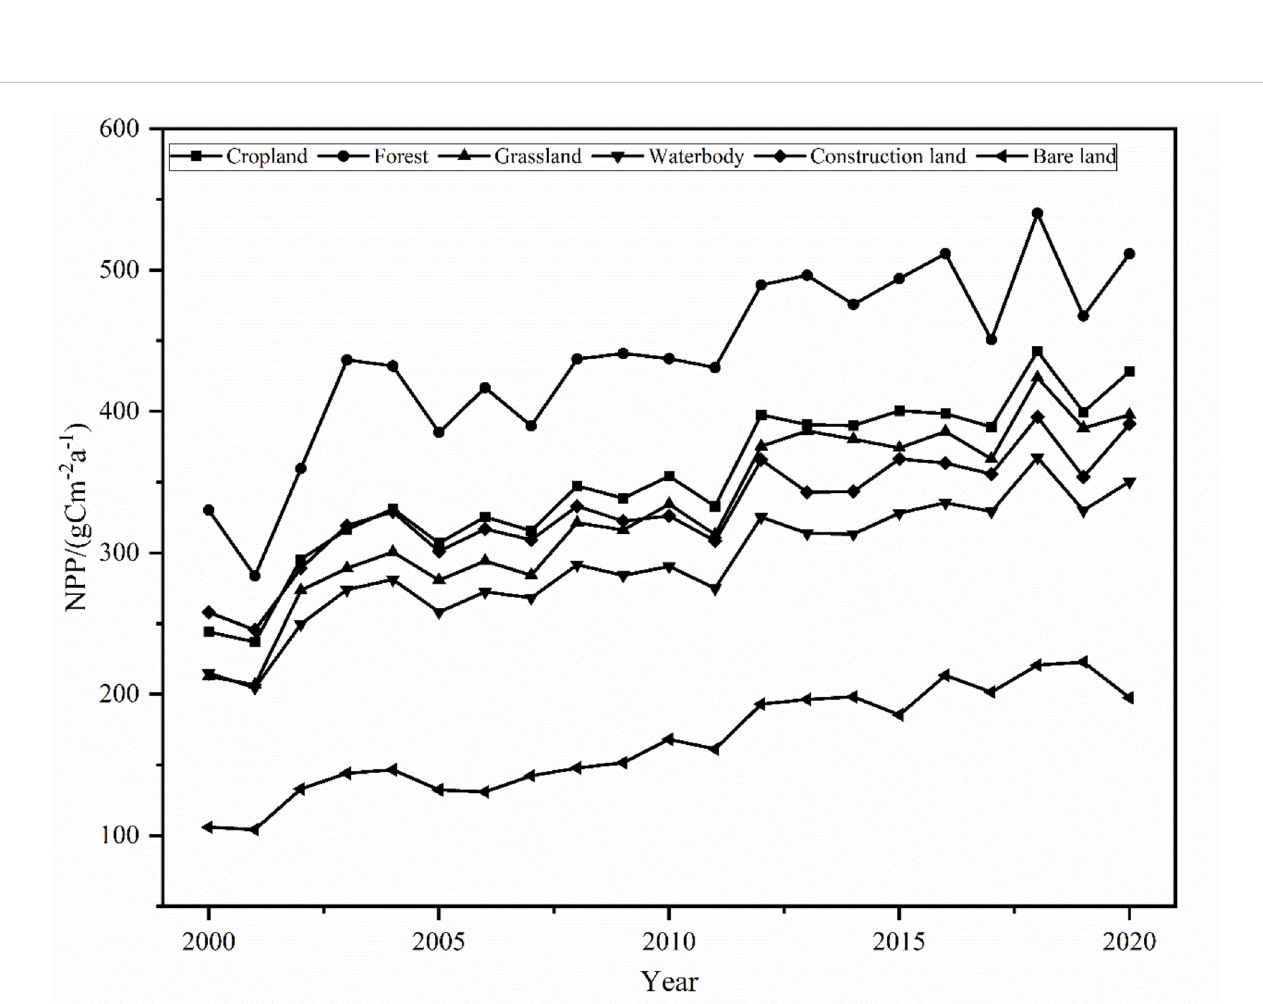
FIGURE 5 Change of NPP with different land use types in the MRYR during